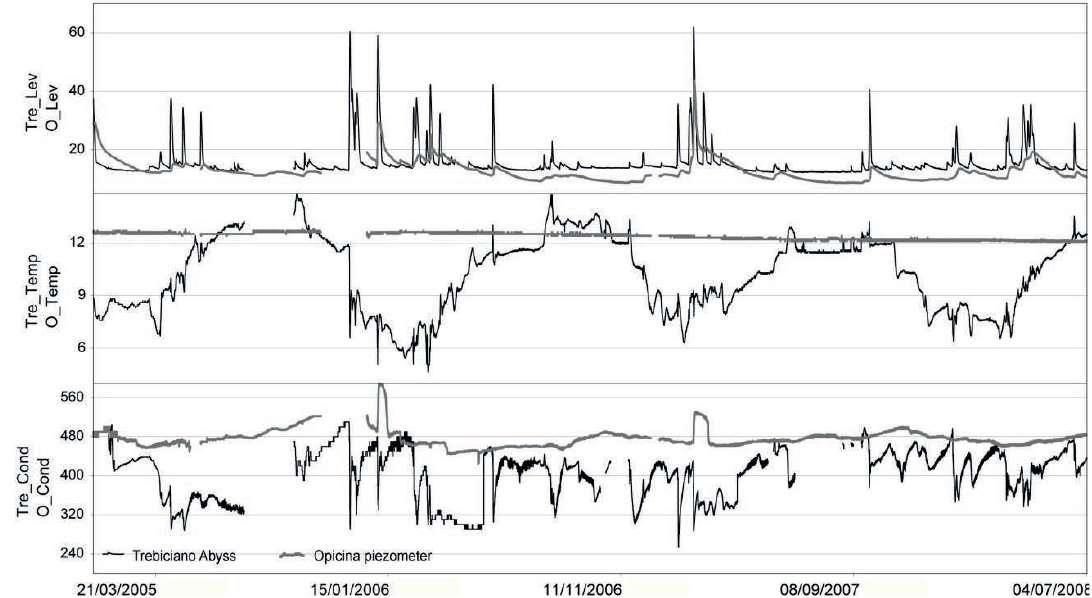
Fig. 3 Three years, 2005–2008, of automatic measures in Trebiciano Abyss and Opicina